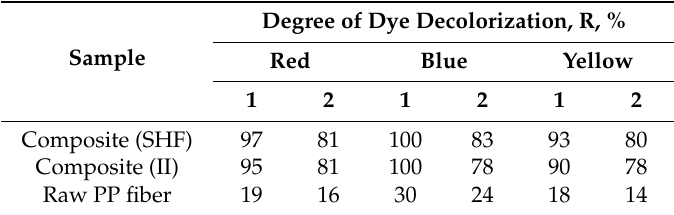
Table 6. The decolorization degree of fat-soluble dyes involving composites in conditions of (1) visible radiation and (2) UV-irradiation (UVI) + H 2 O 2 . The determination error is 3–5%.